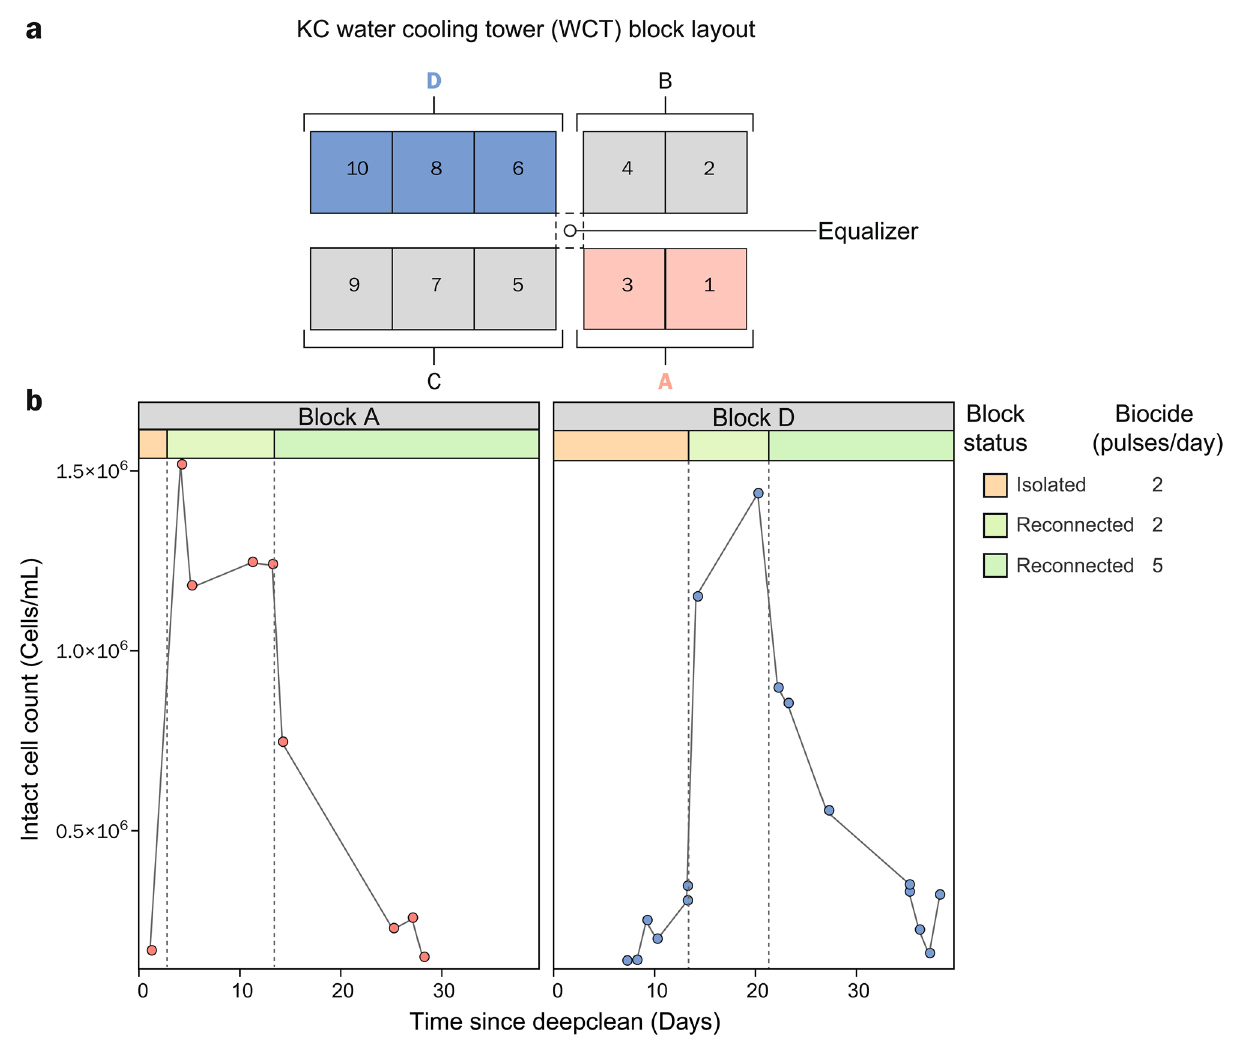
Figure 6. Reconnection of water-cooling towers (WCT) following deep clean treatments (physical biofilm removal) leads to rapid reestablishment of planktonic populations. a —Schematic showing bird’s eye view of WCT basin blocks A–D at plant KC, of which A (red) and D (blue) were sampled during the deep cleaning process. b —Intact cell counts from samples collected in blocks A and D before (yellow region of the plot) and after reconnection (light green) are shown in relation to time since deep clean. The reduction in counts follows the increases in biocide pulse frequency (from 3 to 5 pulses per day), as highlighted by the dark green shaded region of the